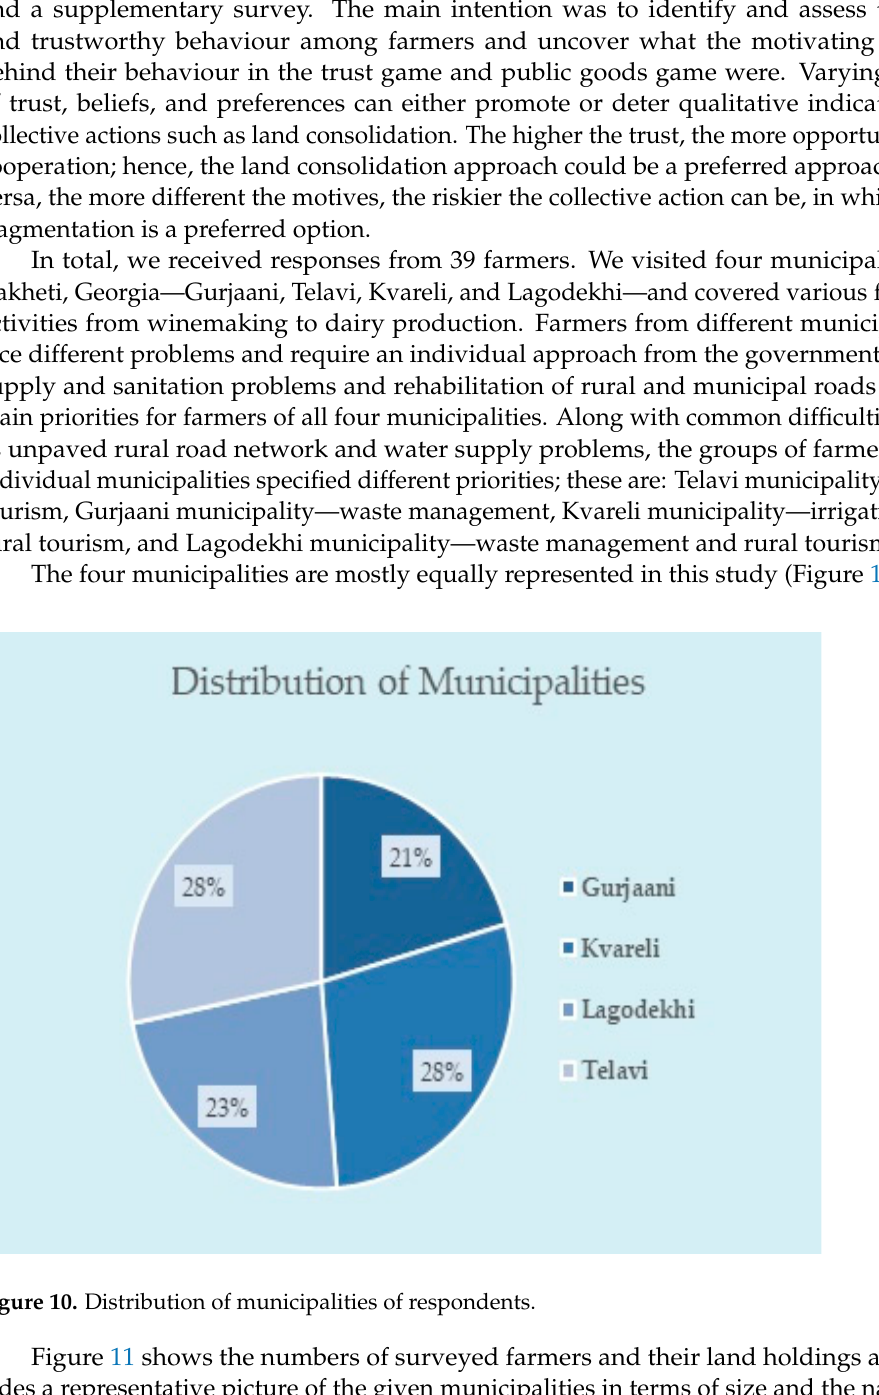
Figure 11. Number of surveyed farmers and total surveyed land holdings in targeted municipalities.